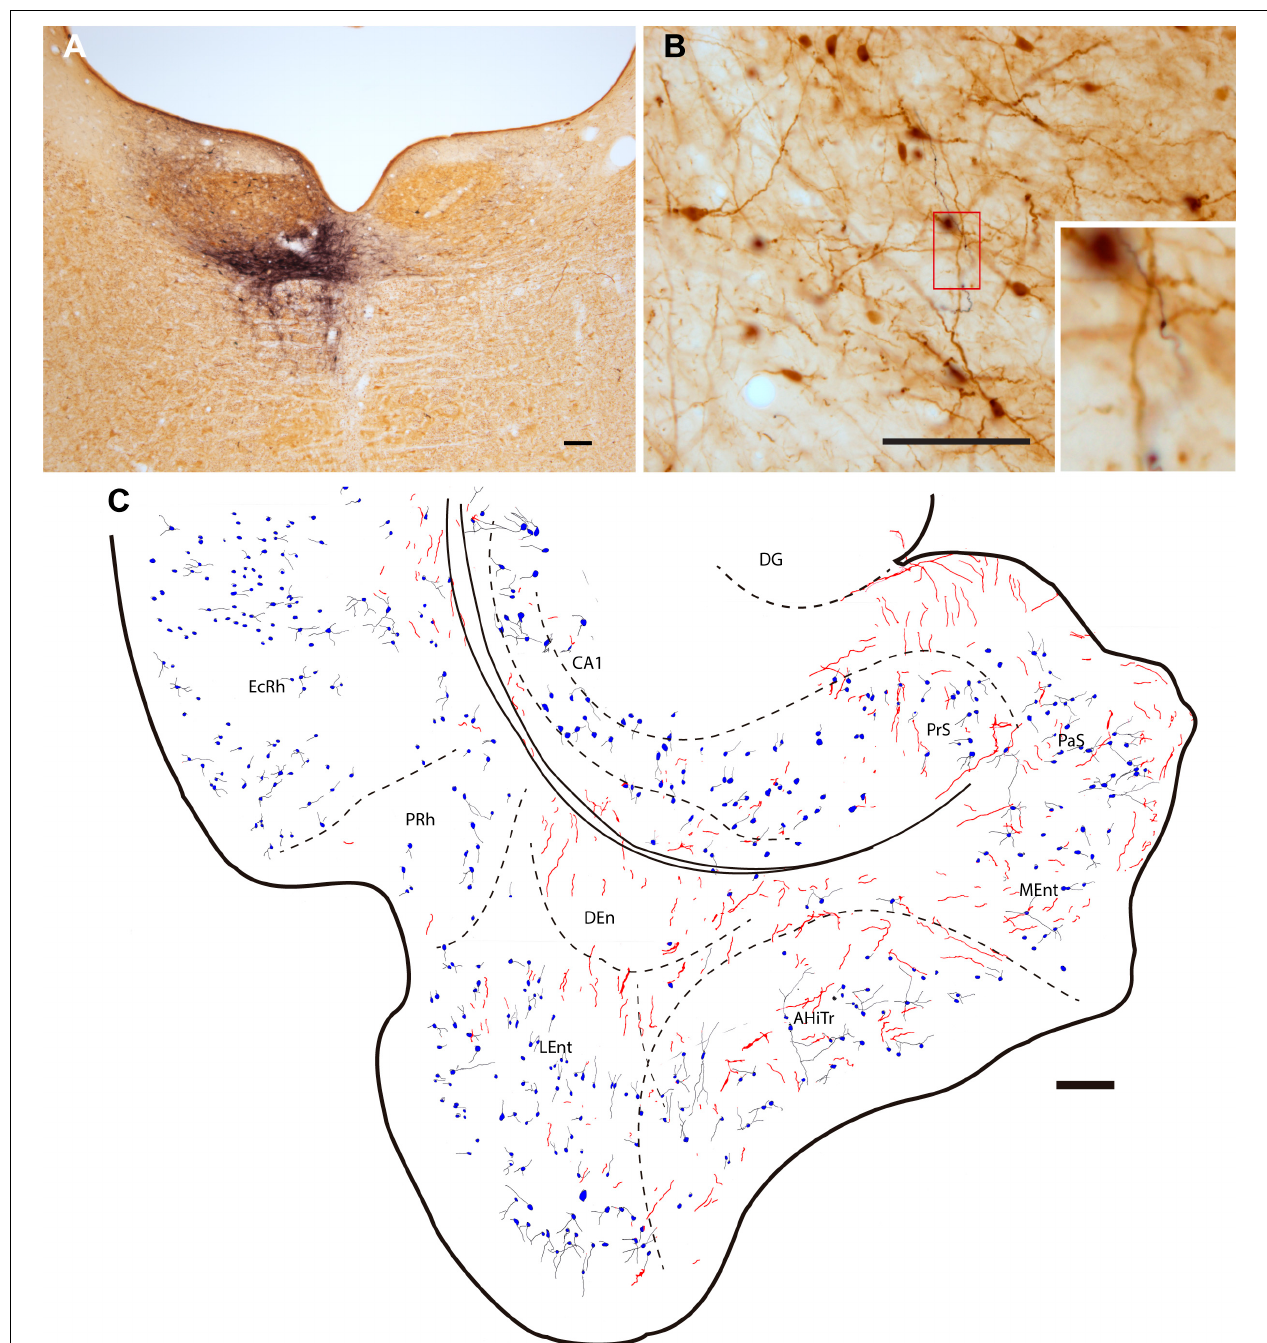
FIGURE 3 | Injection of the anterograde tracer, BDA into one side of the NI and anterograde labeling in the parahippocampal cortex in sections stained for BDA and parvalbumin (PV). (A) Injection site in the NI, Calibration bar 200 µ m, case F54. (B) A section double-stained for BDA and PV illustrating the appearance of anterogradely-labeled fibers (black) and immunoreactive PV neurons in the LEnt and processes (brown). Inset illustrates the boxed area at higher magnification, case F54. Calibration bar 100 µ m. (C) Camera lucida drawing of the general distribution of anterogradely labeled fibers within the parahippocampal cortex, and the distribution and appearance of PV-labeled somata in case F54. Calibration bar 200 µ